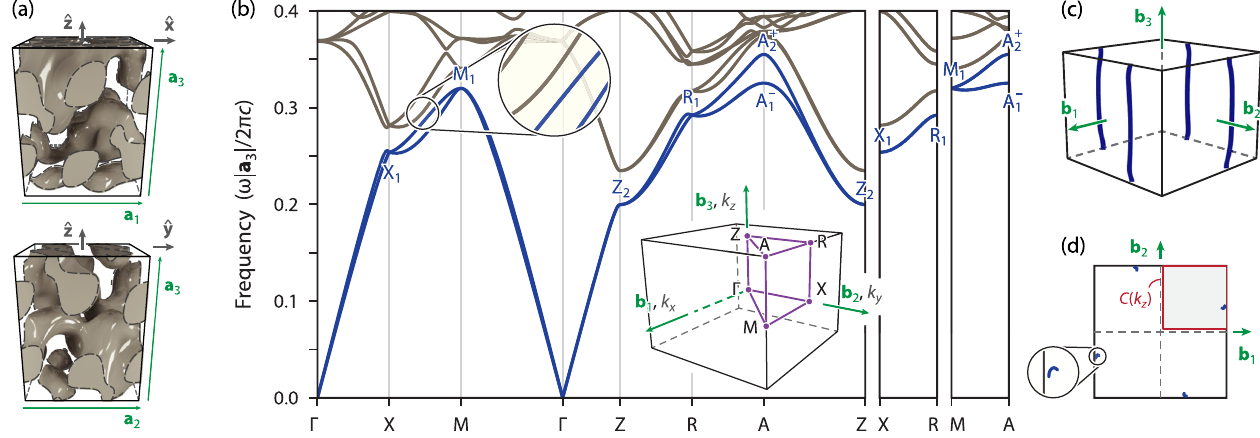
FIG. 3. Photonic topological nongap in space group 86 (P 4 2 = n). (a) PhC unit cell and (b) associated band structure (along indicated BZ path) that realizes a minimum-connectivity ( μ T ¼ 2 ) Γ -enforced topological solution in space group 86 (unit-cell parametrization in Supplemental Table S3 [37]; ε ¼ 16 material in gray, embedded in vacuum with a filling fraction of 35%; a lattice vectors). (c) Four nodal lines connecting bands 2 and 3, running along k ð k x ; k y Þ plane and definition of a fixed- k z loop C ð k z Þ , which encloses a quadrant of the ð k x ; k y Þ plane and a nodal line. Bands 1 – 4 do not touch on C ð k : The Berry phase of bands 2 and 3 (bands 1 and 4) around C ð k z Þ interior of C ð k z Þ